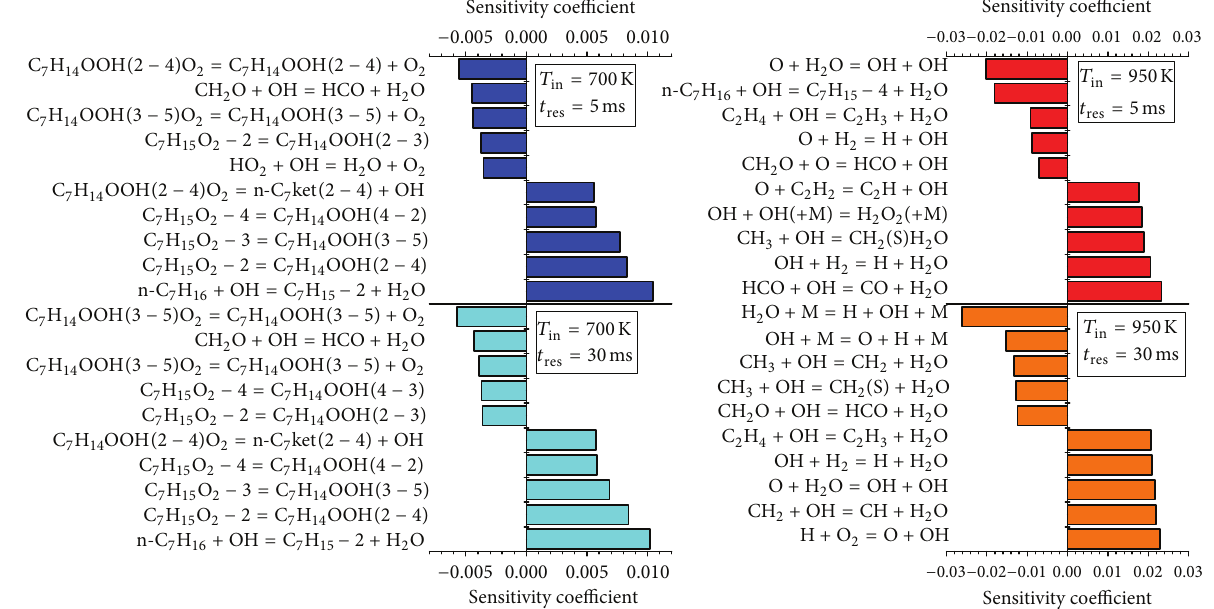
Figure 11: Computed outlet temperature sensitivity coefficients for two inlet temperature values, 𝑇 950 K (ignition regime), and two residence time values ( 𝑡